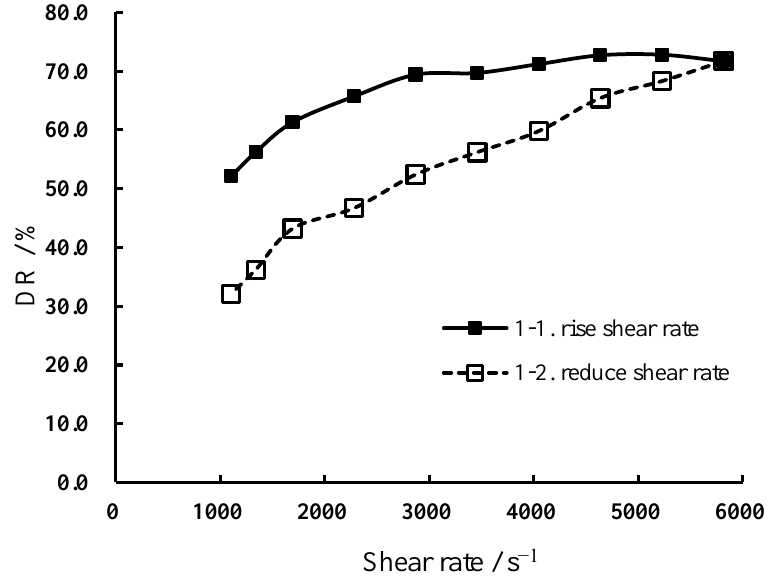
Figure 3. Curve of drag-reduction rate with rise and fall (at the same variation interval) of shear rate. To verify this finding further, we repeated the flow experiment another three times.